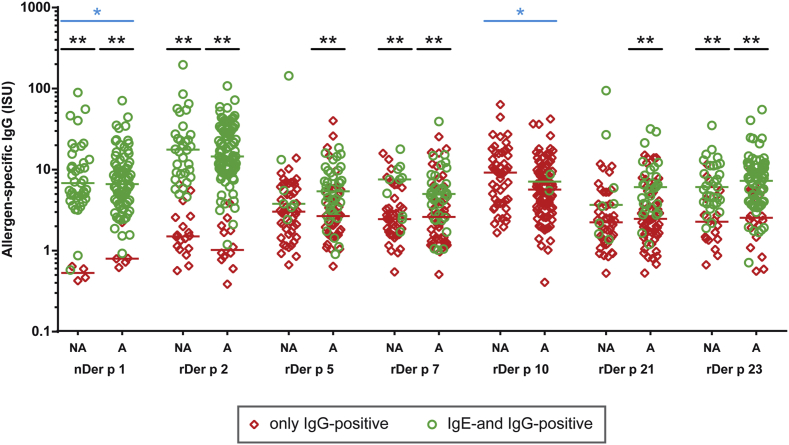
Comparison of allergen-specific IgG levels in nonasthmatic and asthmatic children with HDM allergy containing only allergen-specific IgG or allergen-specific IgE and IgG. Specific IgG levels (y-axes) are displayed for each of the HDM allergens (x-axes) for the nonasthmatic (NA, left columns) and asthmatic (A, right columns) groups. Medians are indicated, and significant differences between only IgG-positive (red diamonds) and IgE- and IgG-positive (green circles) sera are indicated by asterisks. **P < .01. Significant differences between nonasthmatic and asthmatic children in the IgG levels in the only IgG-positive groups (for Der p 1 and Der p 10) are indicated (blue asterisks). *P < .05.